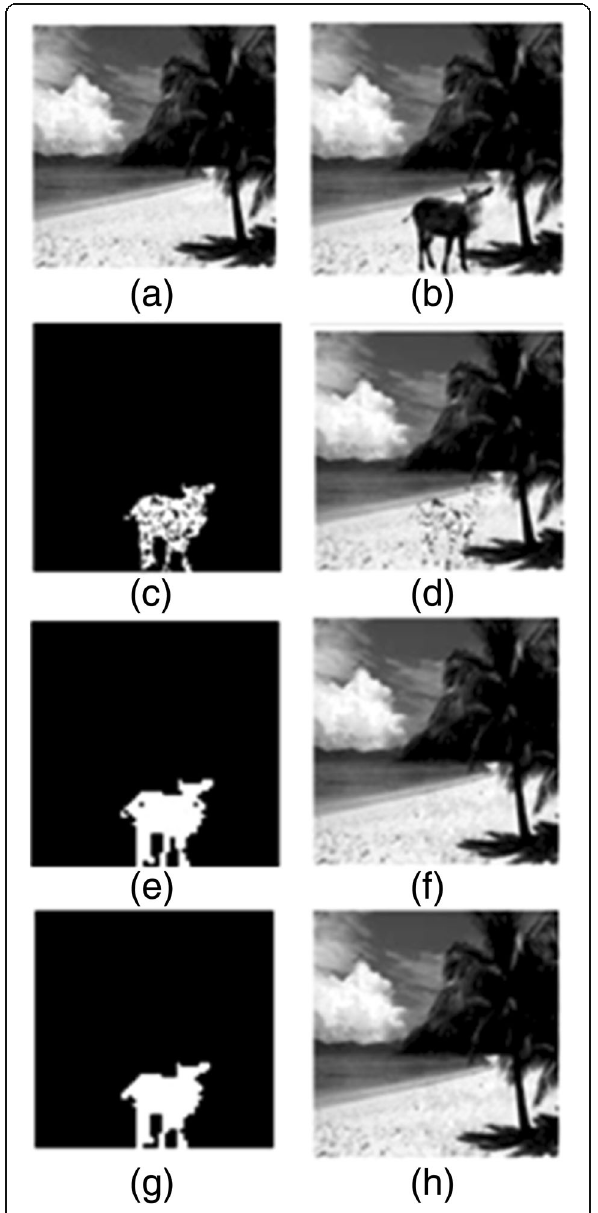
Fig. 9 Example of detecting tamper hierarchically [50]. a The watermarked beach. b Tampered beach. c , e , g Detected erroneous regions of level 1, level 2 and level 3 respectively. d , f , h Recovered beaches of level 1, level 2 and level 3 respectively